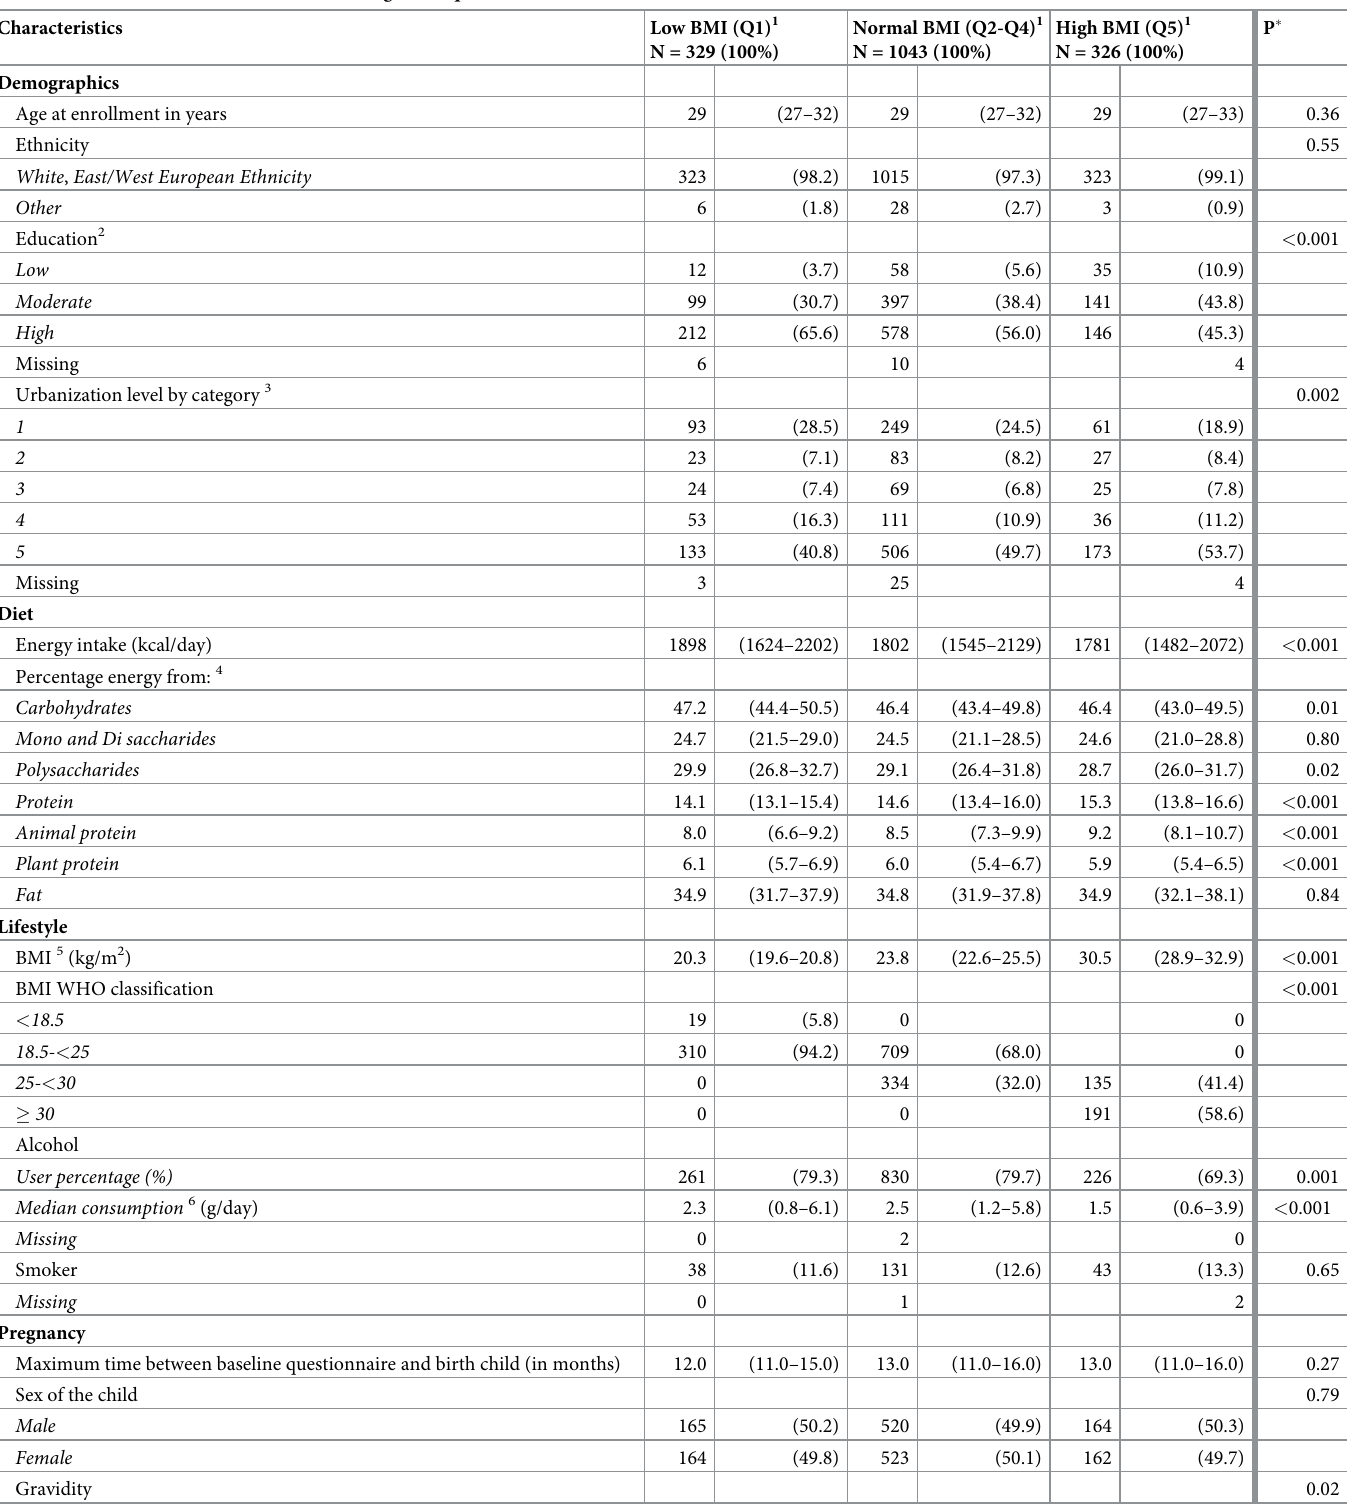
Table 1. Characteristics of the cohort according to the quintile of maternal BMI.